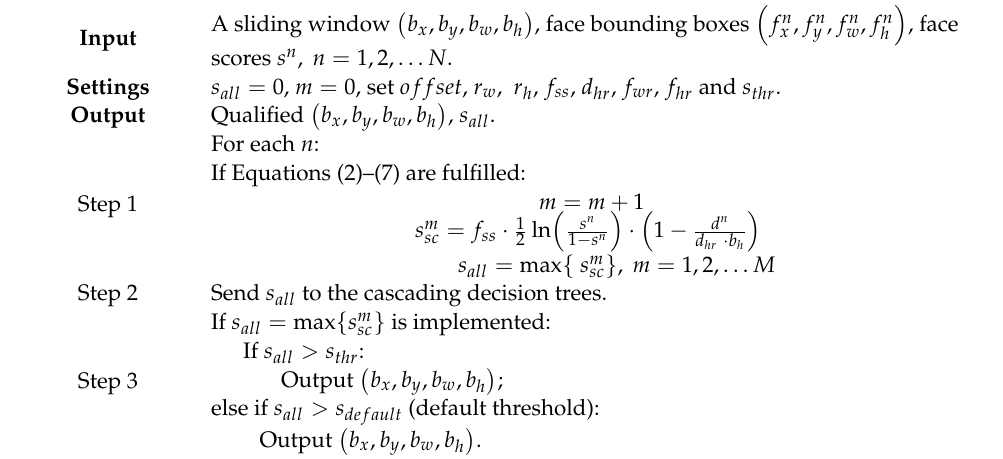
Algorithm 1: Procedure used by the integrated